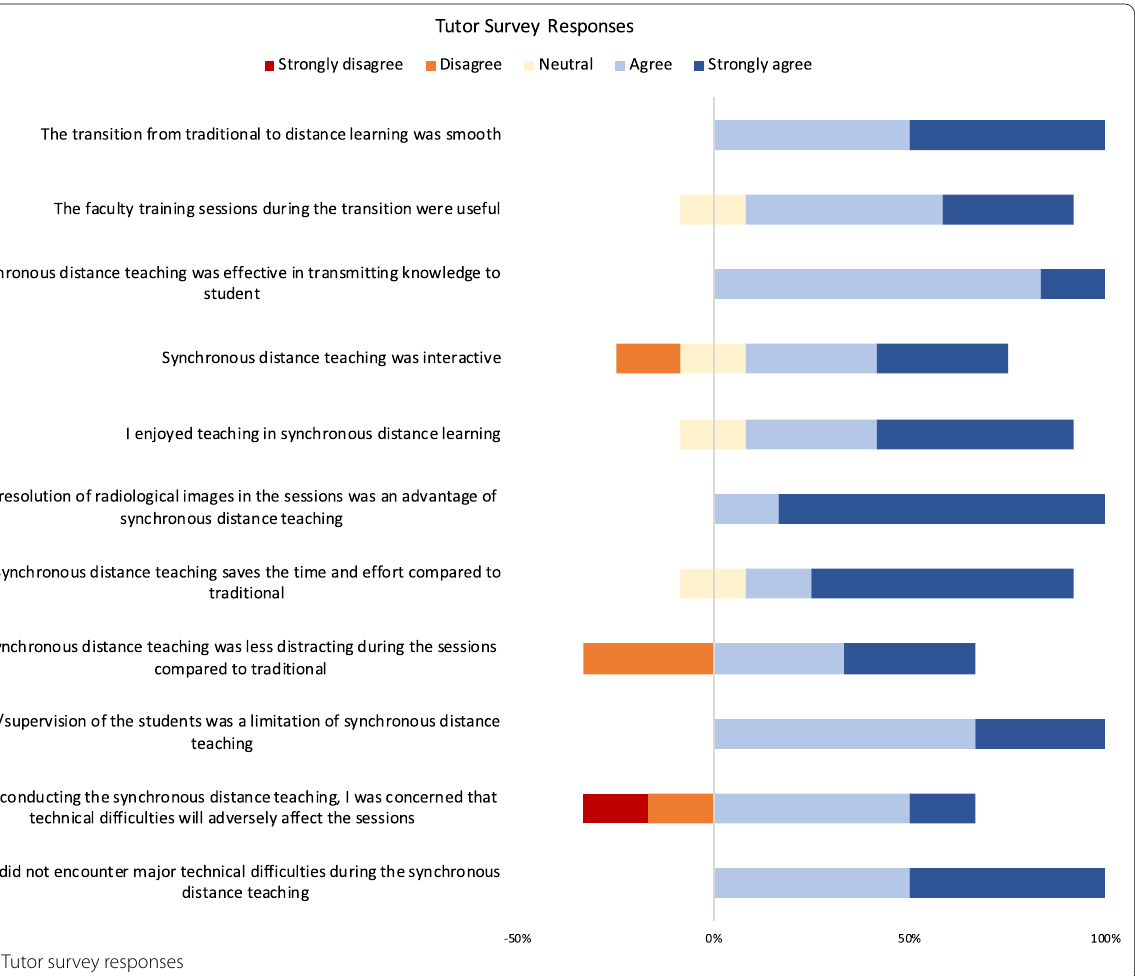
Fig. 2 Tutor survey